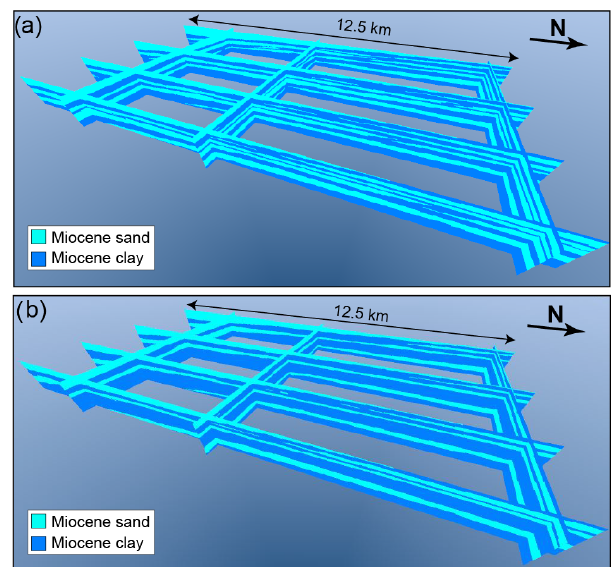
Figure 10. N–S and E–W slices through the two tested 3-D training images seen from north-east. (a) The first TI (TI1), used to generate the unconditioned realization in Fig. 11a. (b) The second TI (TI2), used for the unconditioned realization in Fig. 11b. Vertical exagger- ation = 3 ×